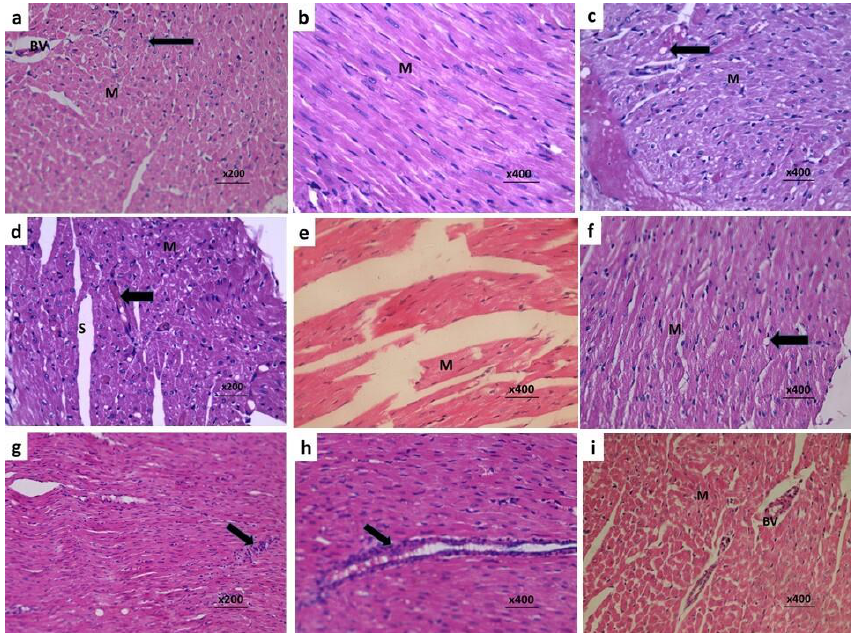
Figure 5. Sections of the cardiac tissues from ( a ) The control group showing transversally cut section of some cardiac muscle fibers (M) with centrally located nuclei (Arrow) and normal-sized blood vessels in between (BV) (H&E × 200); ( b ) The control group showing some cardiac muscle fibers appear longitudinally cut (M) with acidophilic cytoplasm and basophilic central nuclei. The cardiac muscle fibers appear connected and closely adherent (H&E × 400); ( c ) Doxorubicin group showing transversely cut cardiac muscle fibers (M) with marked cytoplasmic vacuolations (Arrow) (H&E × 400); ( d ) Doxorubicin group showing transversely cut cardiac muscle fibers (M) with wide spaces between them (S) and evident interstitial hemorrhage (Arrow) (H&E × 200); ( e ) doxorubicin group showing longitudinally cut cardiac muscle fibers, which appear disorganized into widely separated fragmented bundles (F) (H&E × 400); ( f ) Doxorubicin + fraxetin small dose group showing preserved normal architecture of the cardiac muscle fibers, which appear longitudinally cut (M) with mild cytoplasmic vacuolation (Arrow) (H&E × 400); ( g ) Doxorubicin + fraxetin small dose group showing mild interstitial cellular infiltration (H&E × 200); ( h ) Doxorubicin + fraxetin large dose group showing mild perivascular cellular infiltration (H&E × 400); ( i ) Doxorubicin + fraxetin large dose group showing transversally cut cardiac muscle fibers (M) with centrally located nuclei and normal blood vessel (BV) in between (H&E ×